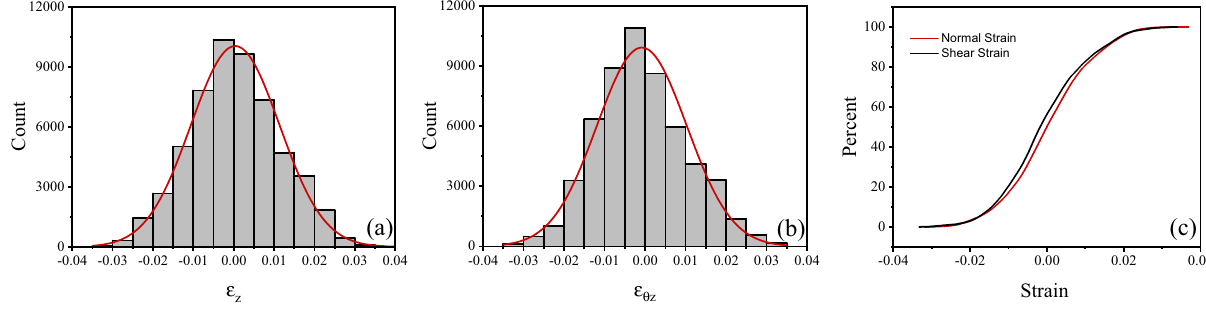
Figure 4. PDF and CDF of the applied axial and shear strains.